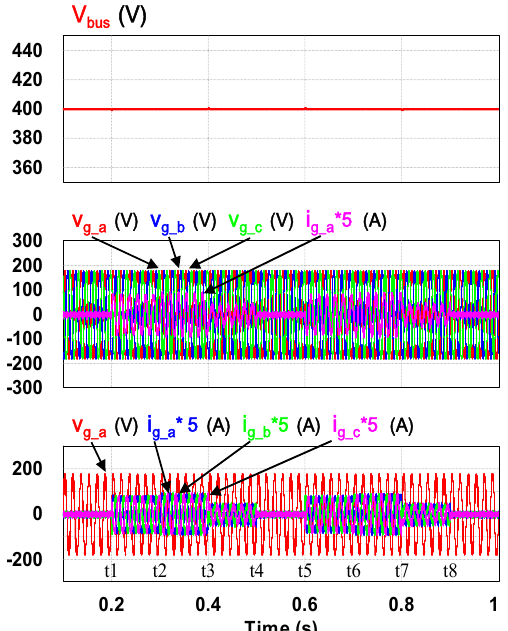
Figure 24. Waveforms of DC bus voltage (top), grid three-phase voltages and a-phase current (mid), grid a-phase voltage and three-phase currents (bottom).